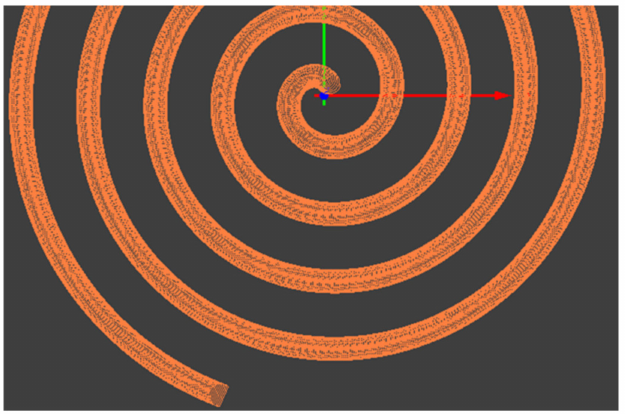
Figure 25. Trochoidal-spiral path. Figure 26 shows the real spiral after milling it (left), and the initial (a), intermediate (b) and final (c) Titanium